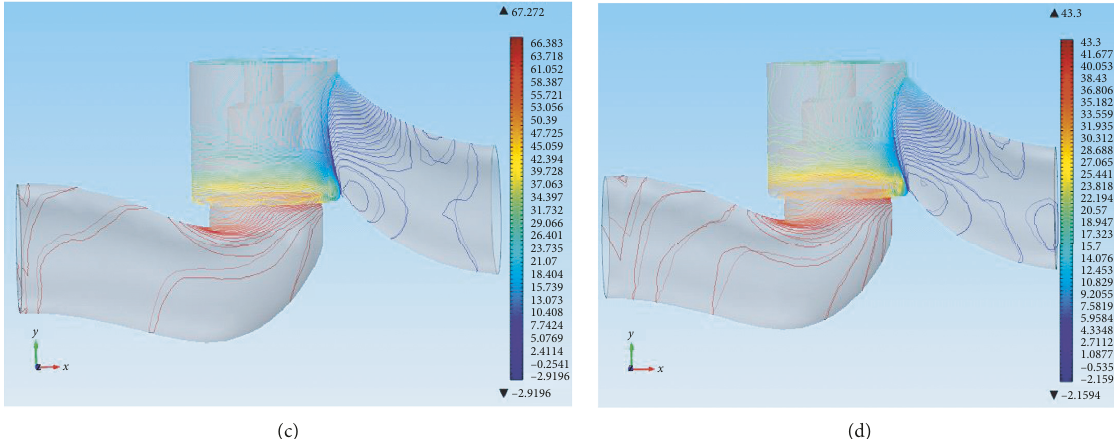
Figure 11: Pressure contours for flat-faced plug at different openings and v � 2 m/s. (a) 10% valve opening; (b) 20% valve opening; (c) 30% valve opening; (d) 40% valve opening.